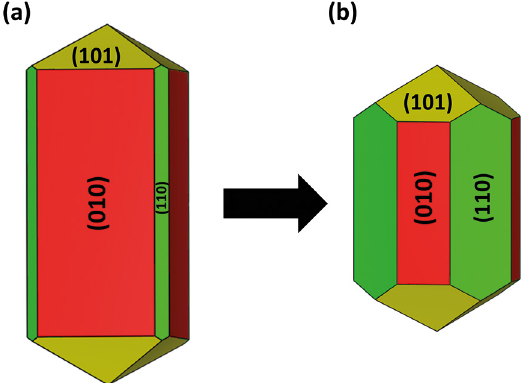
. (a) Unrelaxed structure. 2